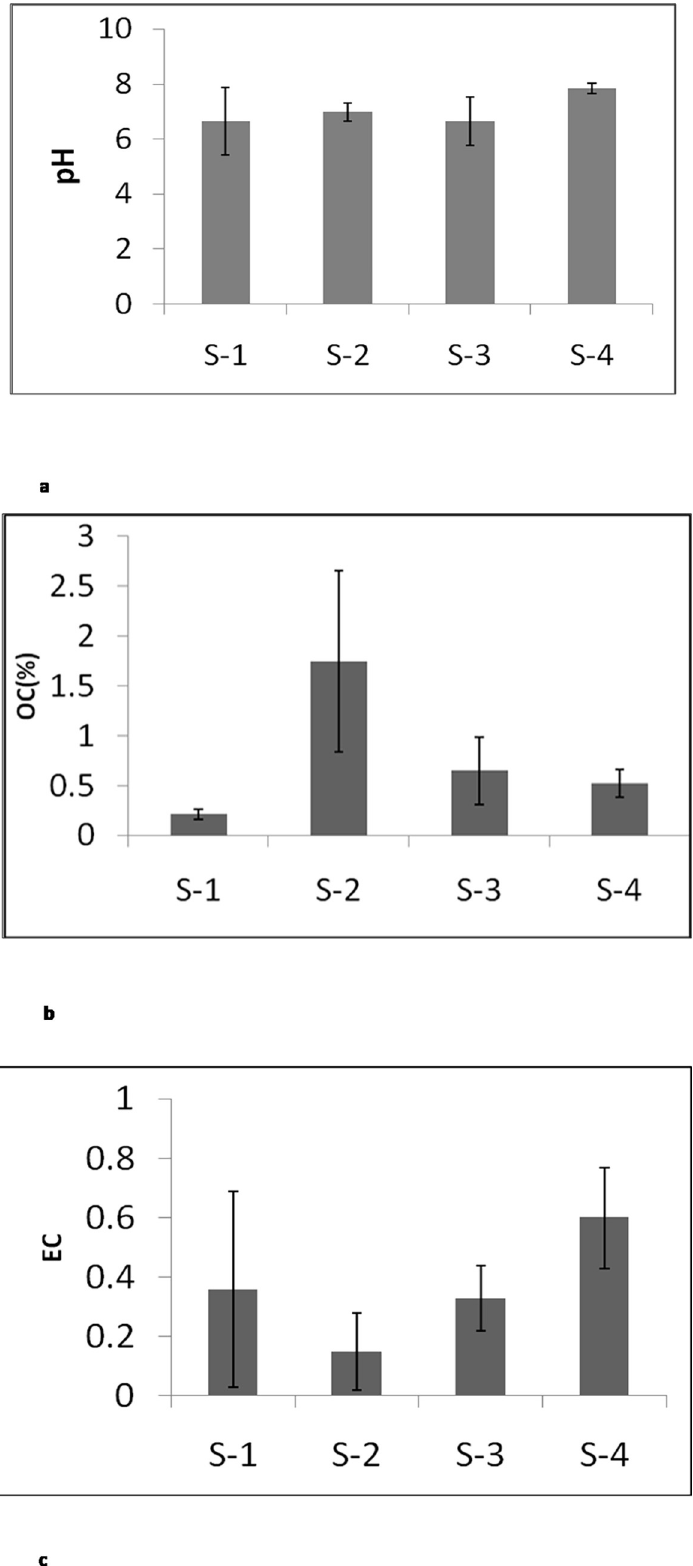
Fig 2. pH (a), EC (b) and OC (c) level in sediments from different sites.